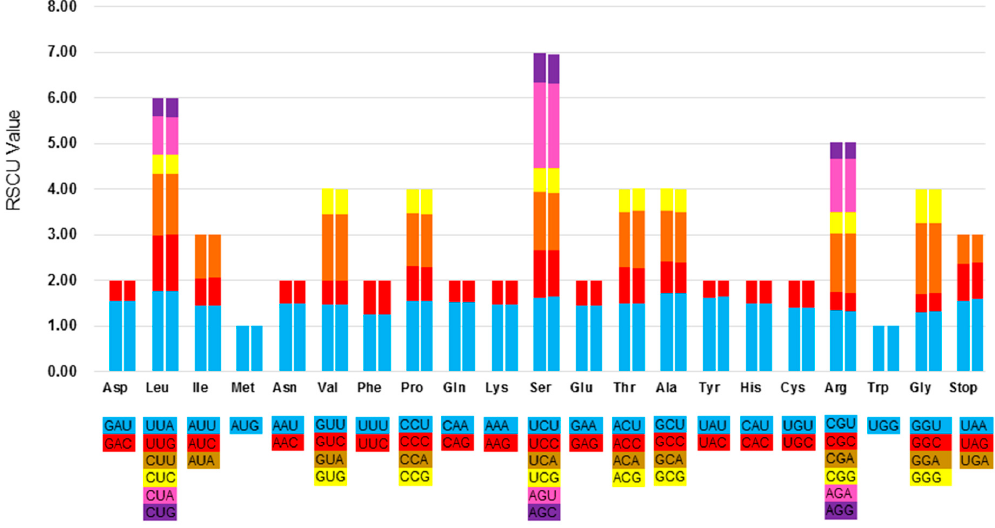
Figure 2. Codon content of 20 amino acid and stop codons in all protein-coding genes of the chloroplast genomes of two Papaver species. The histogram on the left hand side of each amino acid shows codon usage within the P. rhoeas chloroplast genome, whereas the right hand side illustrates the genome of P. orientale .